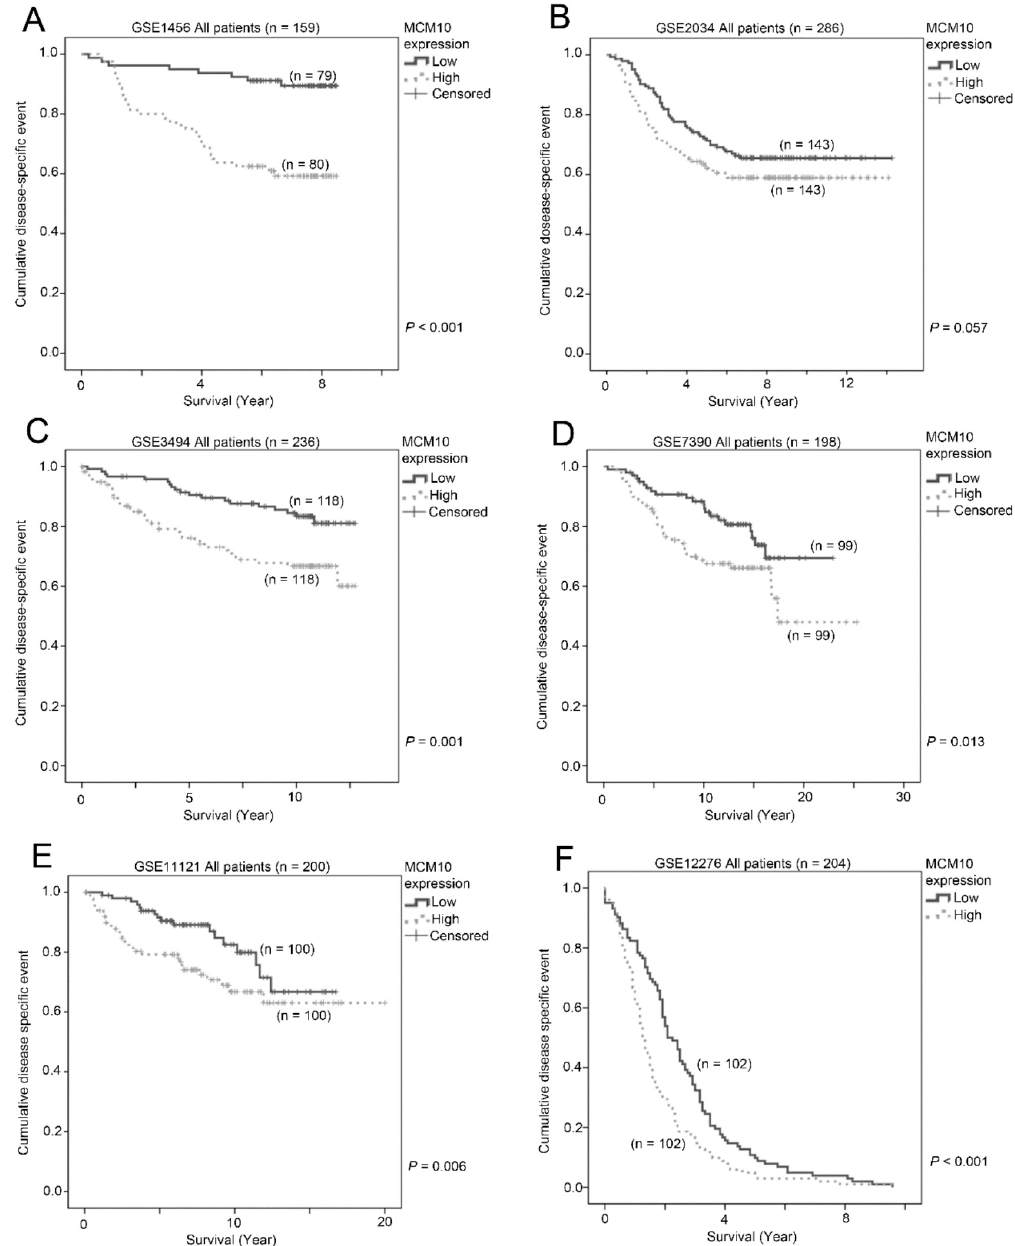
Figure 2. The association between MCM10 expressions and patient survival. Kaplan-Meier plots showing the proportion of patient survival for those with low or high MCM10 expression levels in breast cancer datasets ( A ) GSE1456 ( n = 159); ( B ) GSE2034 ( n = 286); ( C ) GSE3494 ( n = 236); ( D ) GSE7390 ( n = 198); ( E ) GSE11121 ( n = 200); and ( F ) GSE12276 ( n = 204). Table 2. Summary of the survival analysis in breast cancer patient datasets.